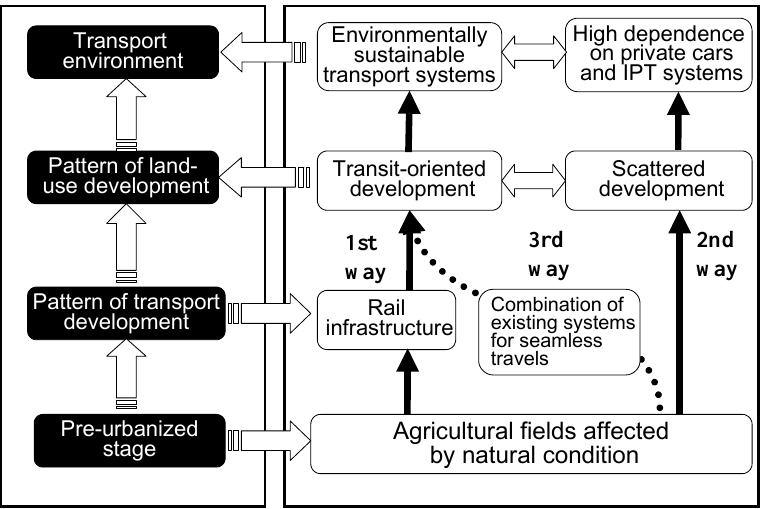
Figure 11. Different scenarios of transport and land use